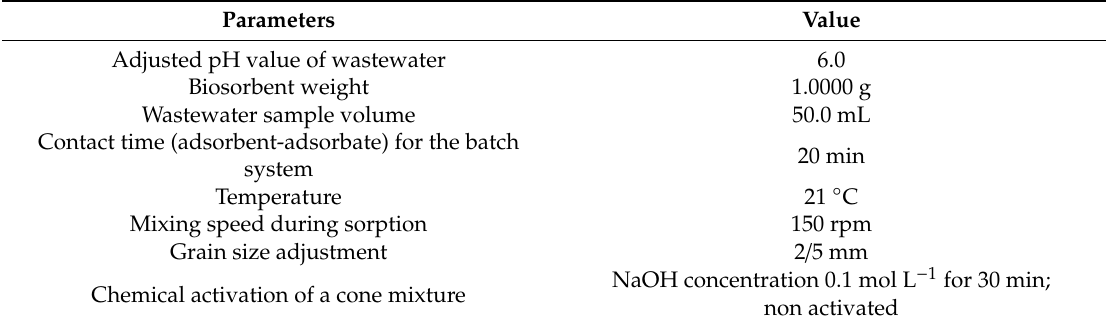
Table 2. Conditions used for laboratory testing of cone mixture for real wastewater after